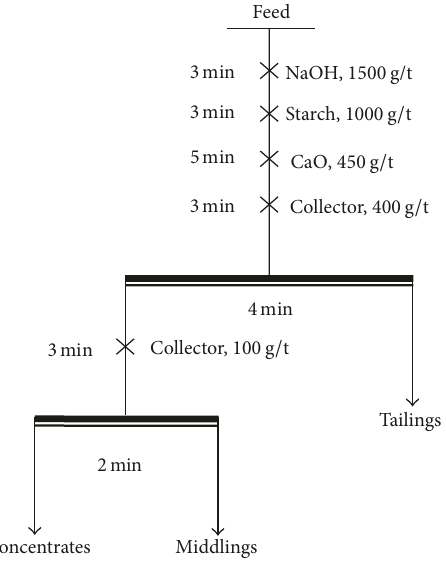
Figure 2: Flow sheet of flotation